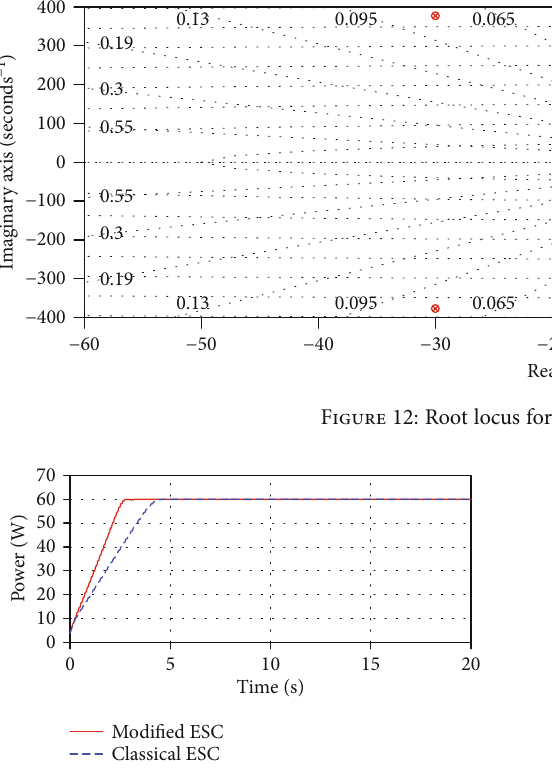
Figure 13: Power curve obtained with the modi fi ed ESC algorithm under STC (25 ° C and 1000 W/m 2 ).